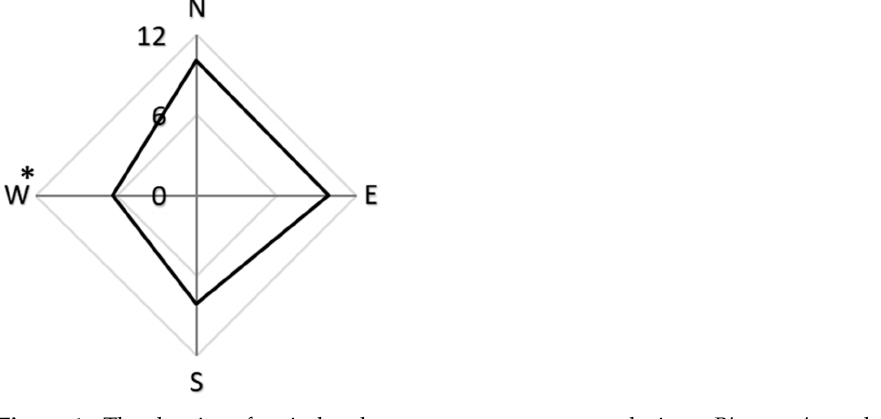
Figure 2. The density of resin beads and emerged wood wasps per square meter on log sections with heights of 1.5, 3, 4.5, 6, and 7.5 m above ground. The height was significant only for resin bead density ( X 2 = 21.63, p < 0.01), not for the emergence of Sirex noctilio ( p = 0.28), S. nigricornis ( p = 0.08), and Ibalia leucospoides ( p = 0.50).